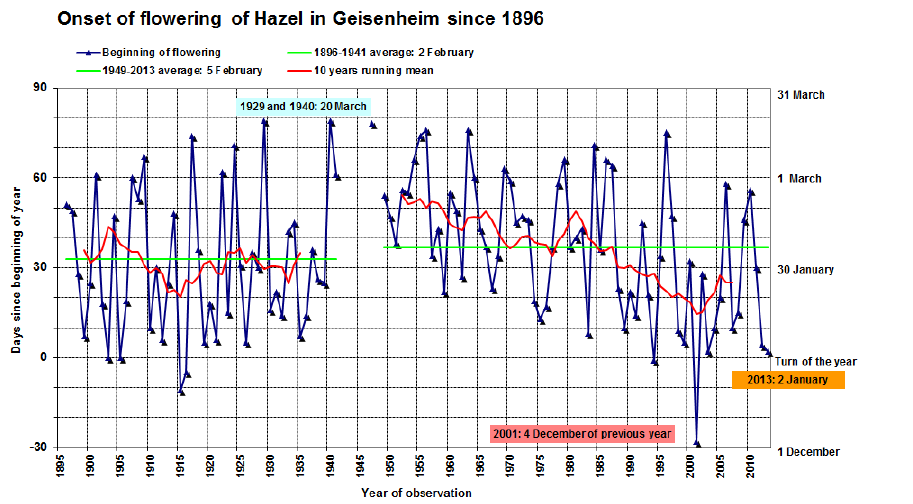
Figure 3. Some phenological records held by the research station at Geisenheim go back to 1896. These show a marked shift towards earlier flowering times over the past 60years.